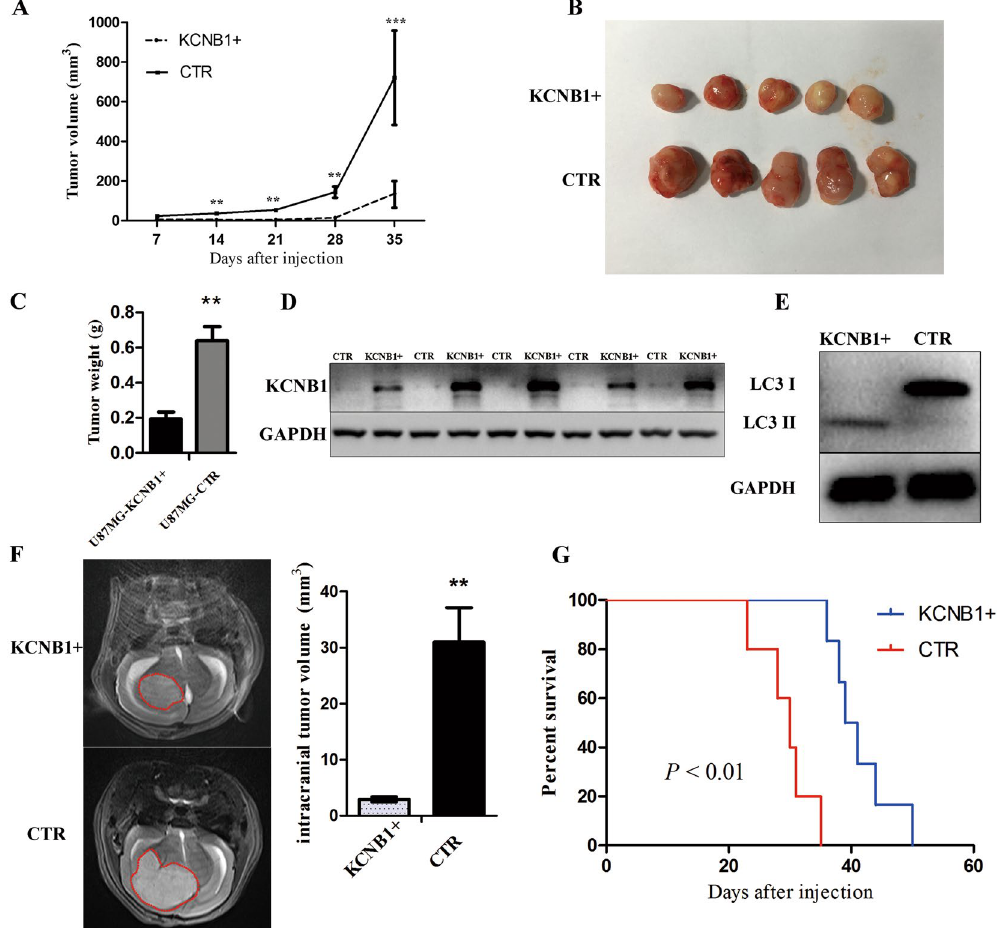
Figure 5. Effects of KCNB1 in vivo . ( A ) Tumor volumes were measured every seven days. Mean tumor volume was calculated. The results are presented as the mean ± SD. ( B ) A xenograft model consisting of nude mice with U87MG-KCNB1 + or U87MG-CTR cells injected subcutaneously into the 6-week-old mice (n = 5/group). KCNB1 overexpression impairs subcutaneous xenograft growth of glioma cells. ( C ) The tumor weight was measured for each xenograft. ( D ) KCNB1 protein levels in U87-KCNB1 + tumor tissues (n = 5) and U87-CTR tumor tissues (n = 5) were analyzed by western blotting. ( E ) Western blot analysis showing the overexpression of LC3-II in lysates from frozen tissues from the U87MG-KCNB1 + mice compared with the U87MG-CTR mice. ( F ) The sizes of orthotopic brain tumor xenografts were monitored by MRI after 4 weeks. KCNB1 overexpression in U87MG cells impairs tumorigenesis upon orthotopic injection. n = 5 mice per group. ( G ) Survival curves in the two groups of mice. Statistically significant differences were determined by two-sided log- rank test. * p < 0.05, ** p < 0.01, *** p <